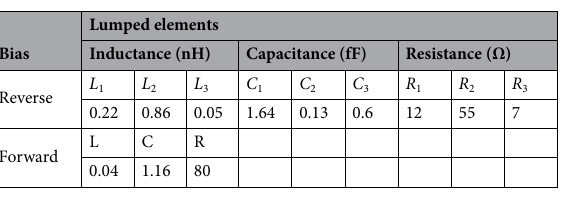
Table 3. Quantities of the lumped elements of the equivalent circuit models of Fig. 5a and b.